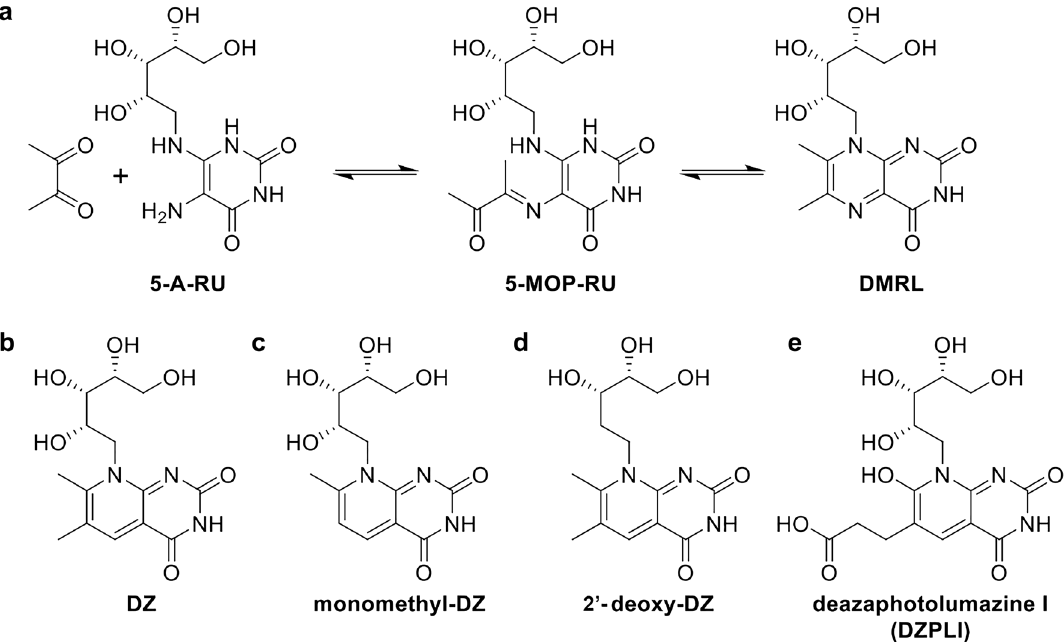
Figure 1. Proposed chemical structures for deaza-molecules. ( a ) Reaction scheme from 5-A-RU to DMRL indicating reversible reactions via ketimine hydrolysis. ( b ) Proposed chemical structure of DZ, the deaza- version of DMRL. ( c ) Proposed monomethyl-DZ chemical structure. ( d ) Proposed 2 ′ -deoxy-DZ chemical structure. ( e ) Proposed DZ-PLI chemical